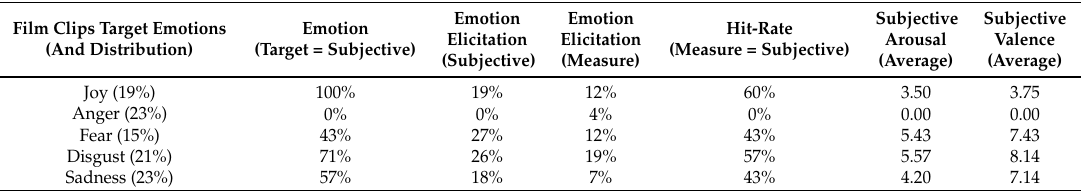
Table 3. Film clips’ elicitation analysis.